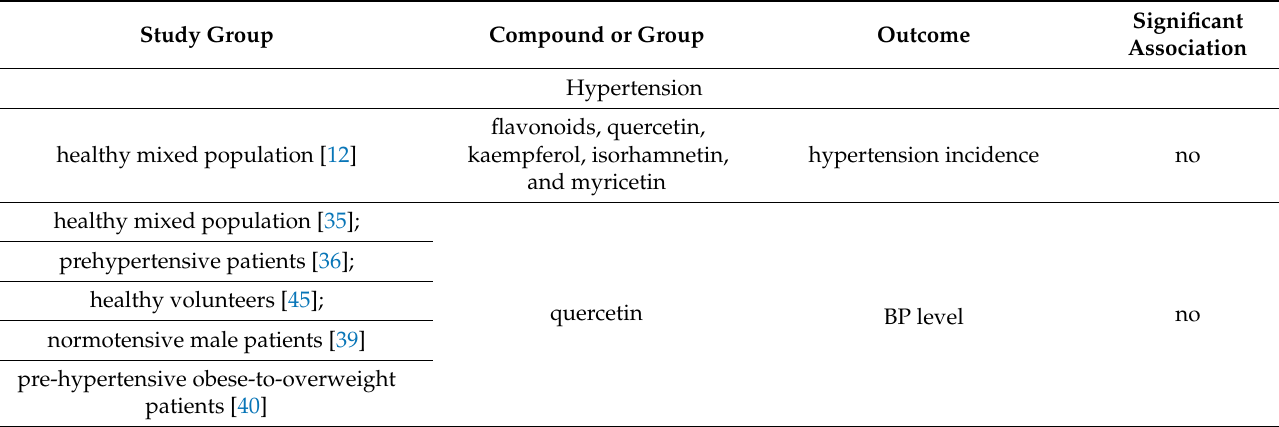
Table 2. The simplified summary of flavonols’ impact on selected CV risk